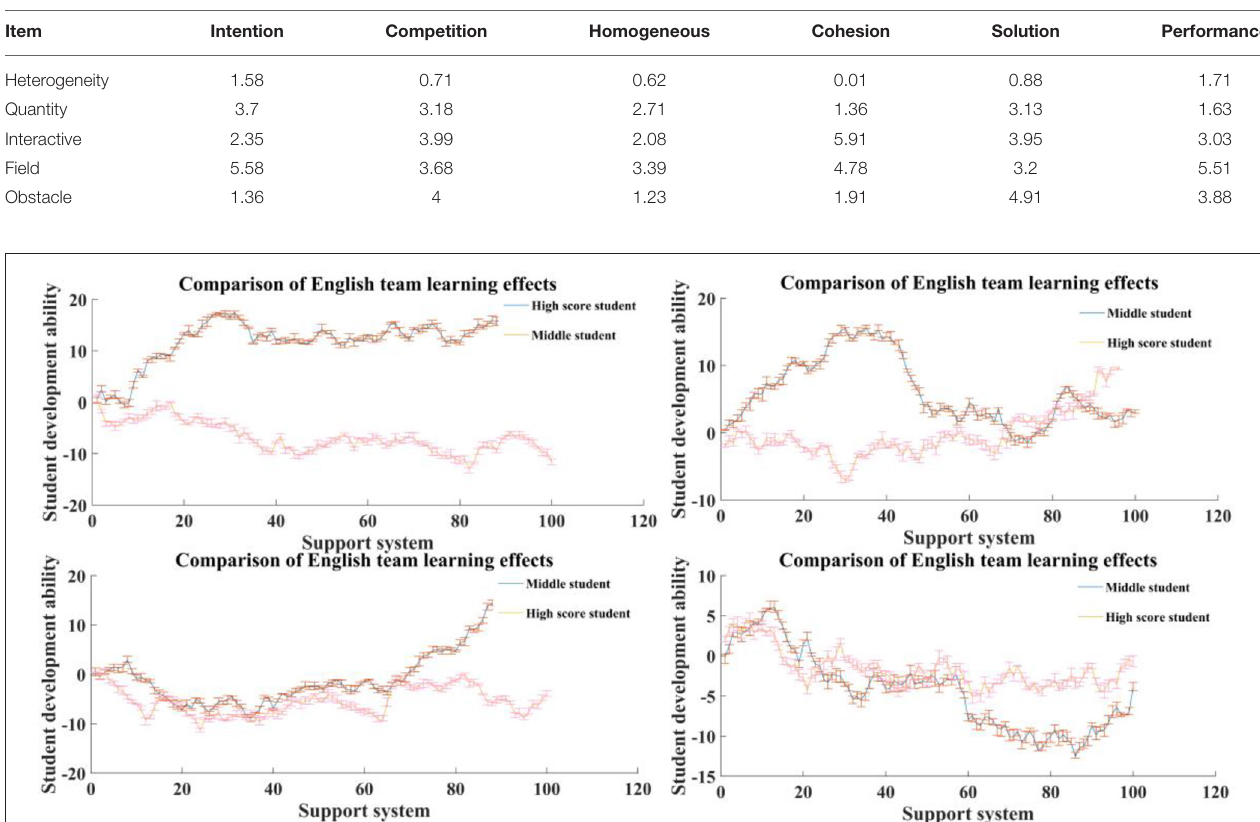
TABLE 6 | English team learning as an innovation and entrepreneurship activity.